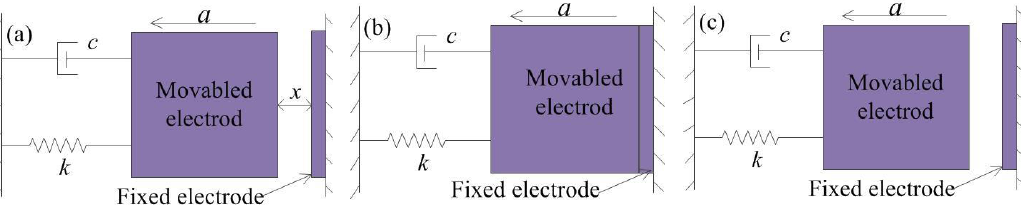
Figure 2. Rigid contact process of inertial switch. ( a ) the acceleration is applied to the inertial switch, ( b ) the movable electrode contacts with fixed electrode, ( c ) the movable electrode returns to original position.